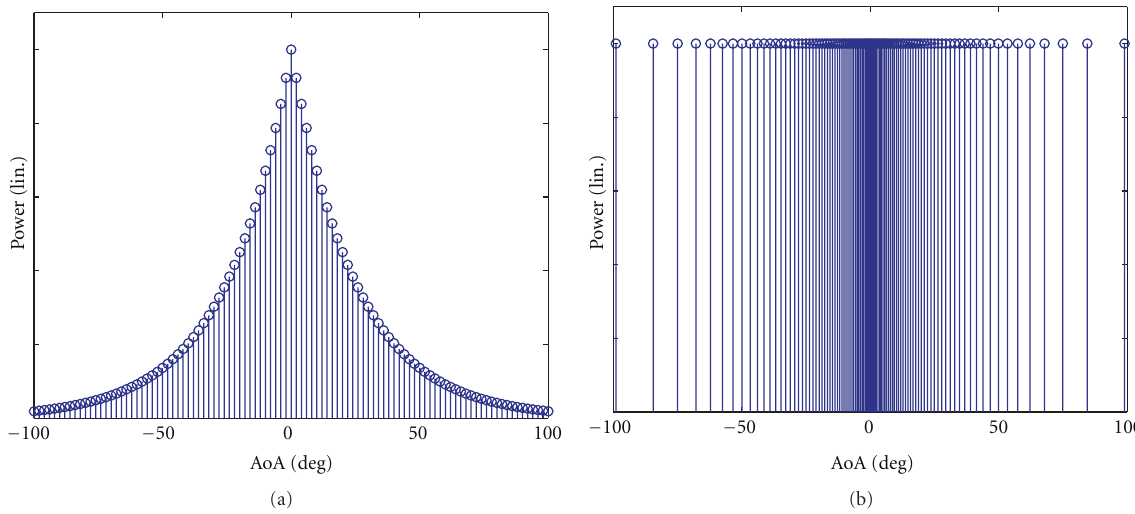
Figure 5: Uniform (a) and non-uniform (b) sampling of Laplacian function shaped PAS.